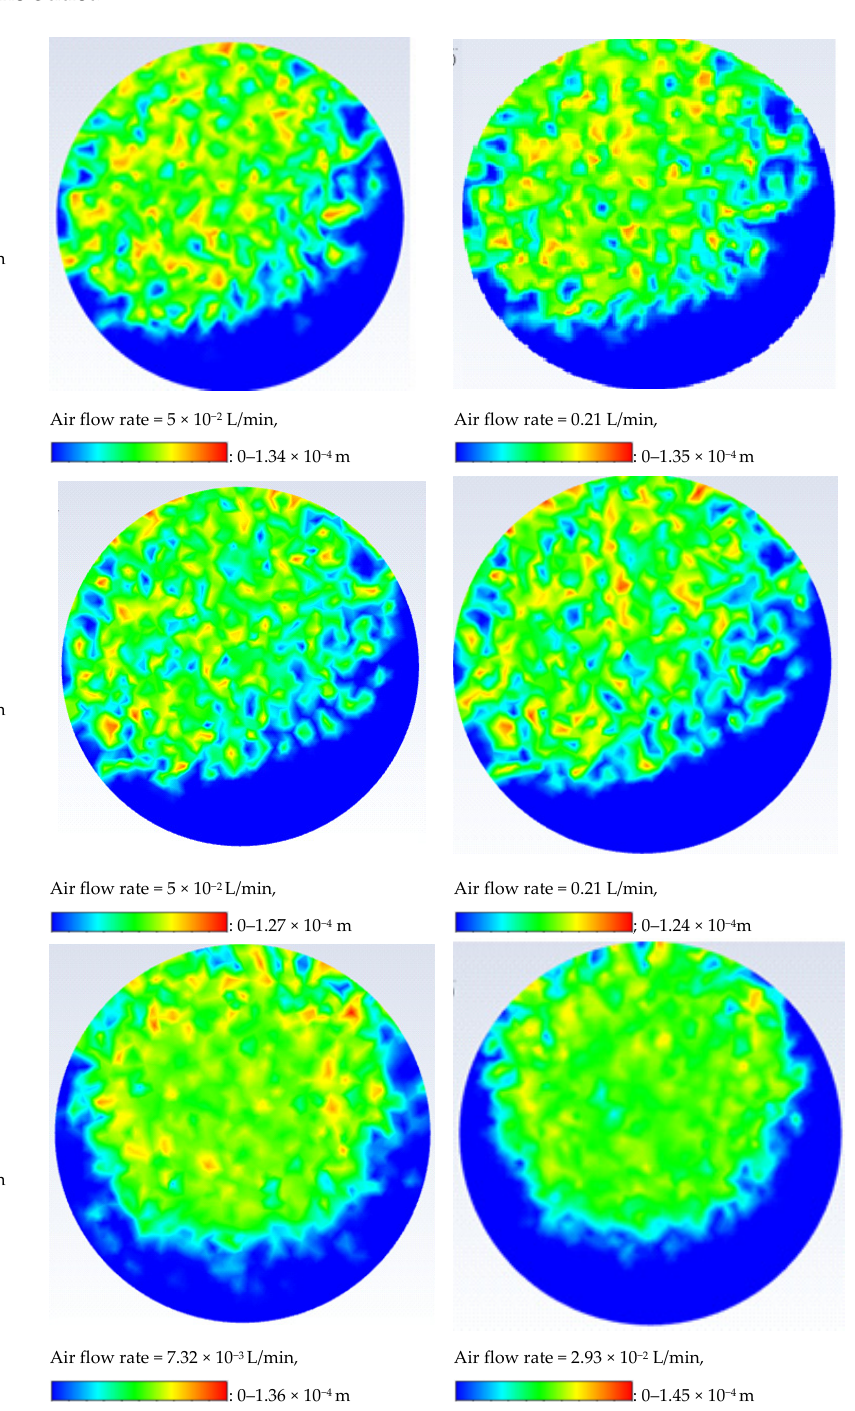
Figure 9. The contours for drop diameter distribution at the exit of the microbubble generator for cases of different water and air flow rates.